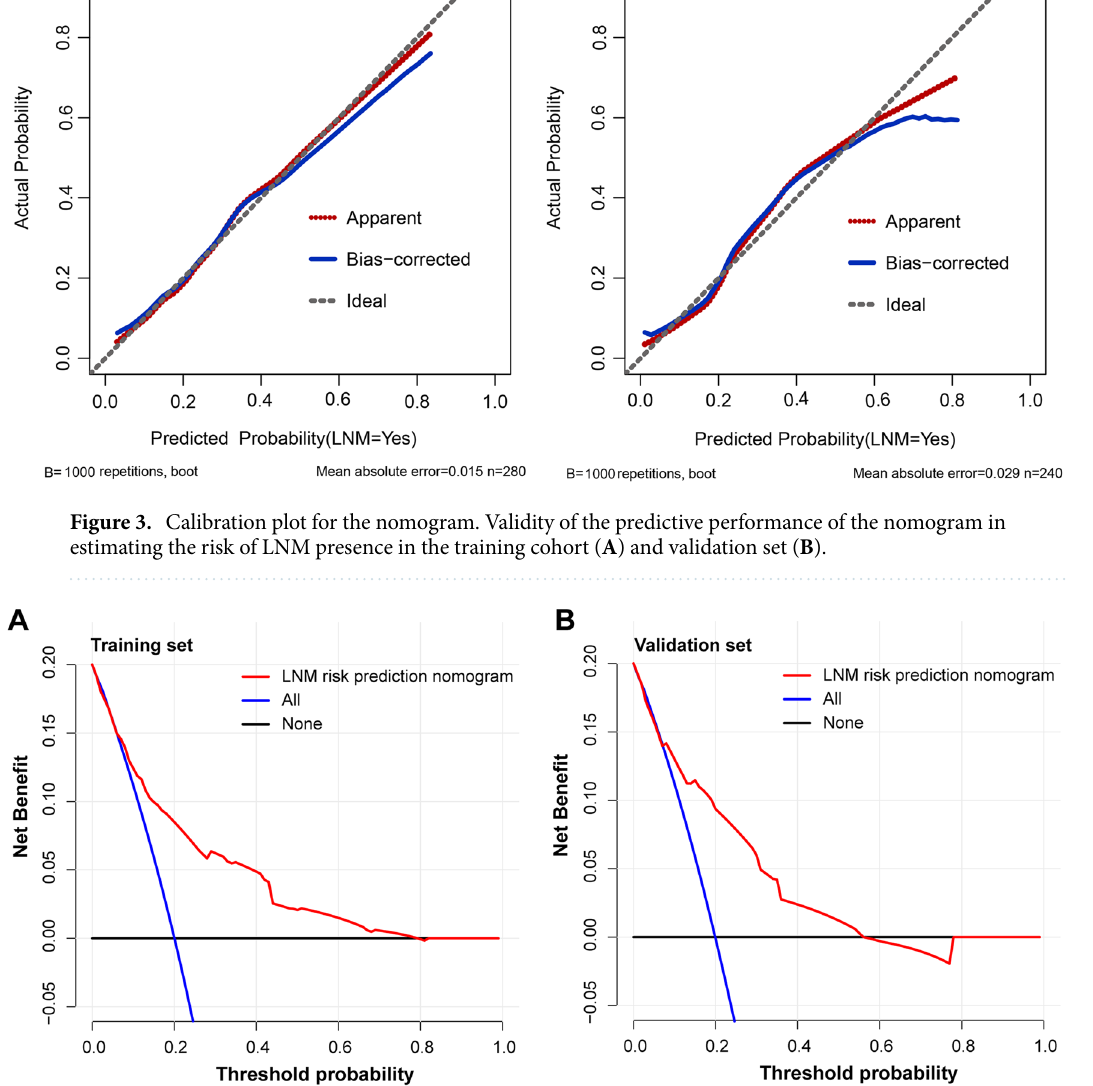
Figure 4. Decision curves of the nomogram predicting LNM in training set ( A ) and validation set ( B